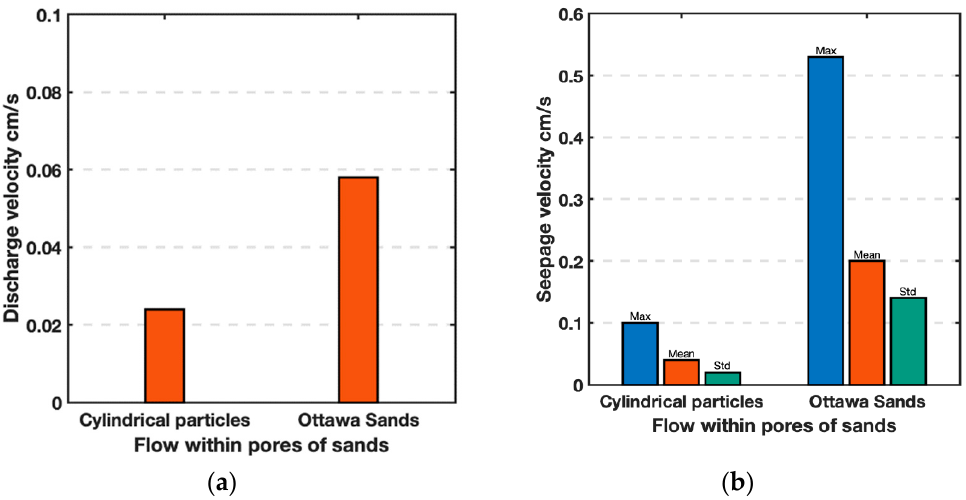
Figure 12. Comparison of average ( a ) discharge and ( b ) seepage velocities between perfect cylinders and simulated Ottawa sand particles.